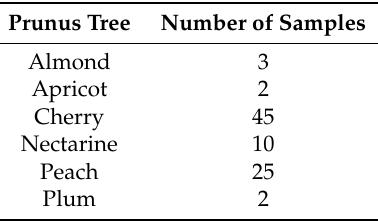
Table 5. Prunus samples analyzed by high throughput sequencing during this study.